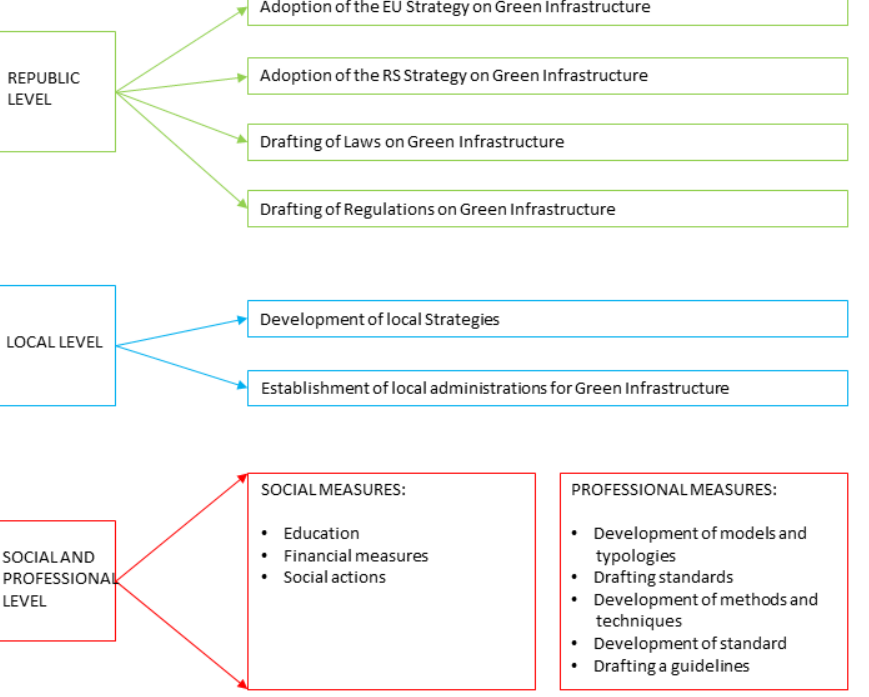
Figure 12. Legal framework RS and green infrastructure disadvantages and potential (http://bel- lab.rs/wp-content/uploads/2021/03/CLEVER-Cities-_-TNOC.pdf, accessed on 30 August 2022).